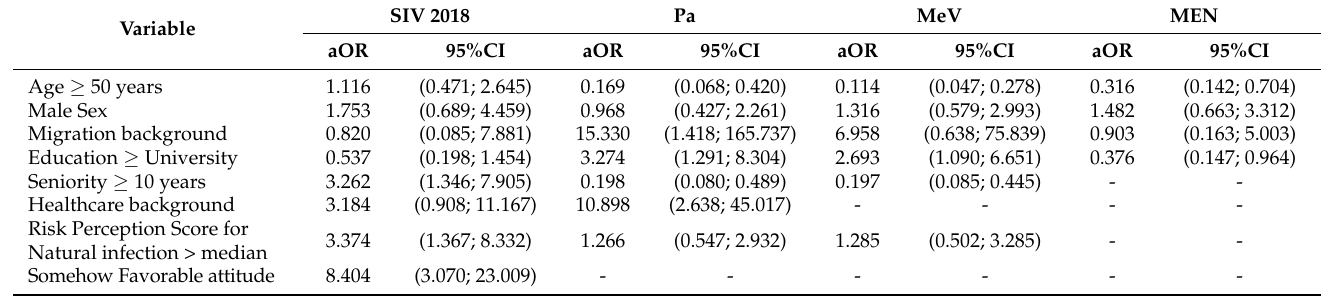
Table 5. Multivariable analysis of the association between individual factors and having been vaccinated against seasonal influenza (SIV) 2018, pertussis (Pa), measles (MeV), meningitis (any vaccine, MEN). Multivariate odds ratios (aOR), with their respective 95% confidence intervals (95% CI) were calculated through binary regression analysis. The models included, as an outcome variable, being previously vaccinated, and as an effector variable, all demographic factors and individual factors in which univariate analyses were associated with a vaccination status with p < 0.05. Note: HCW = healthcare